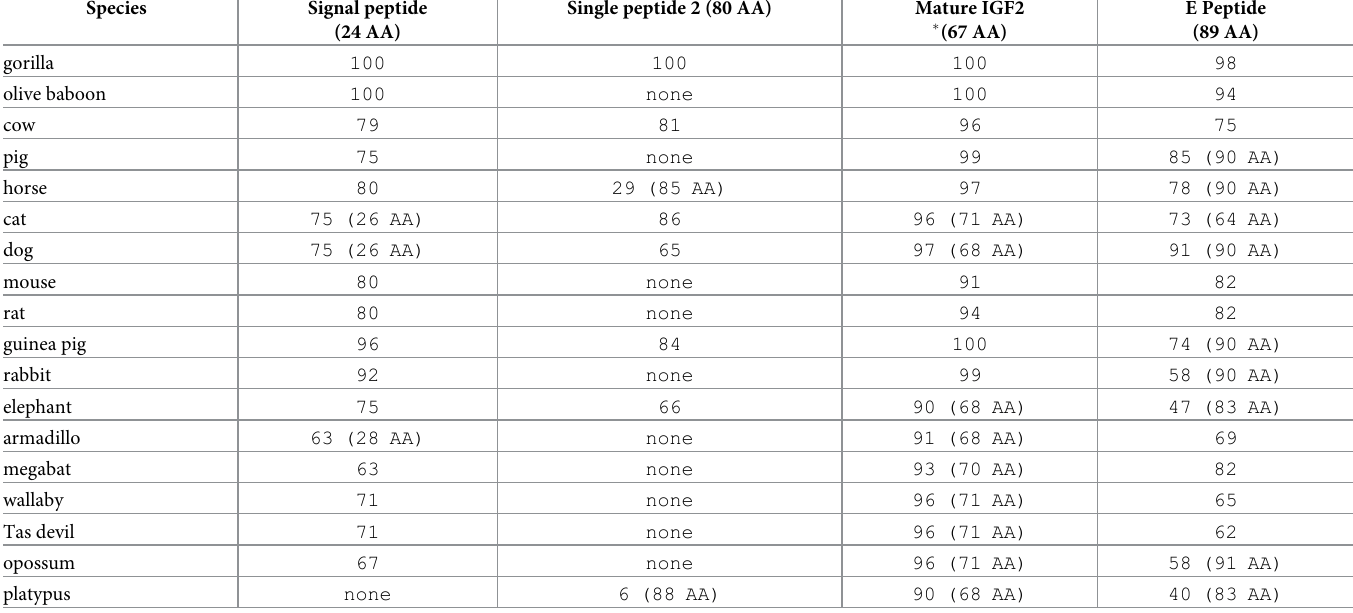
Table 3. Amino acid identities with human IGF2